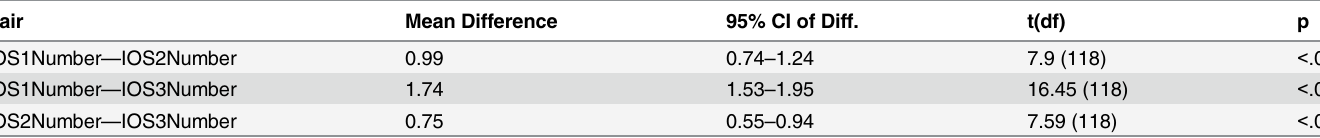
Table 8. Post-hoc tests for the